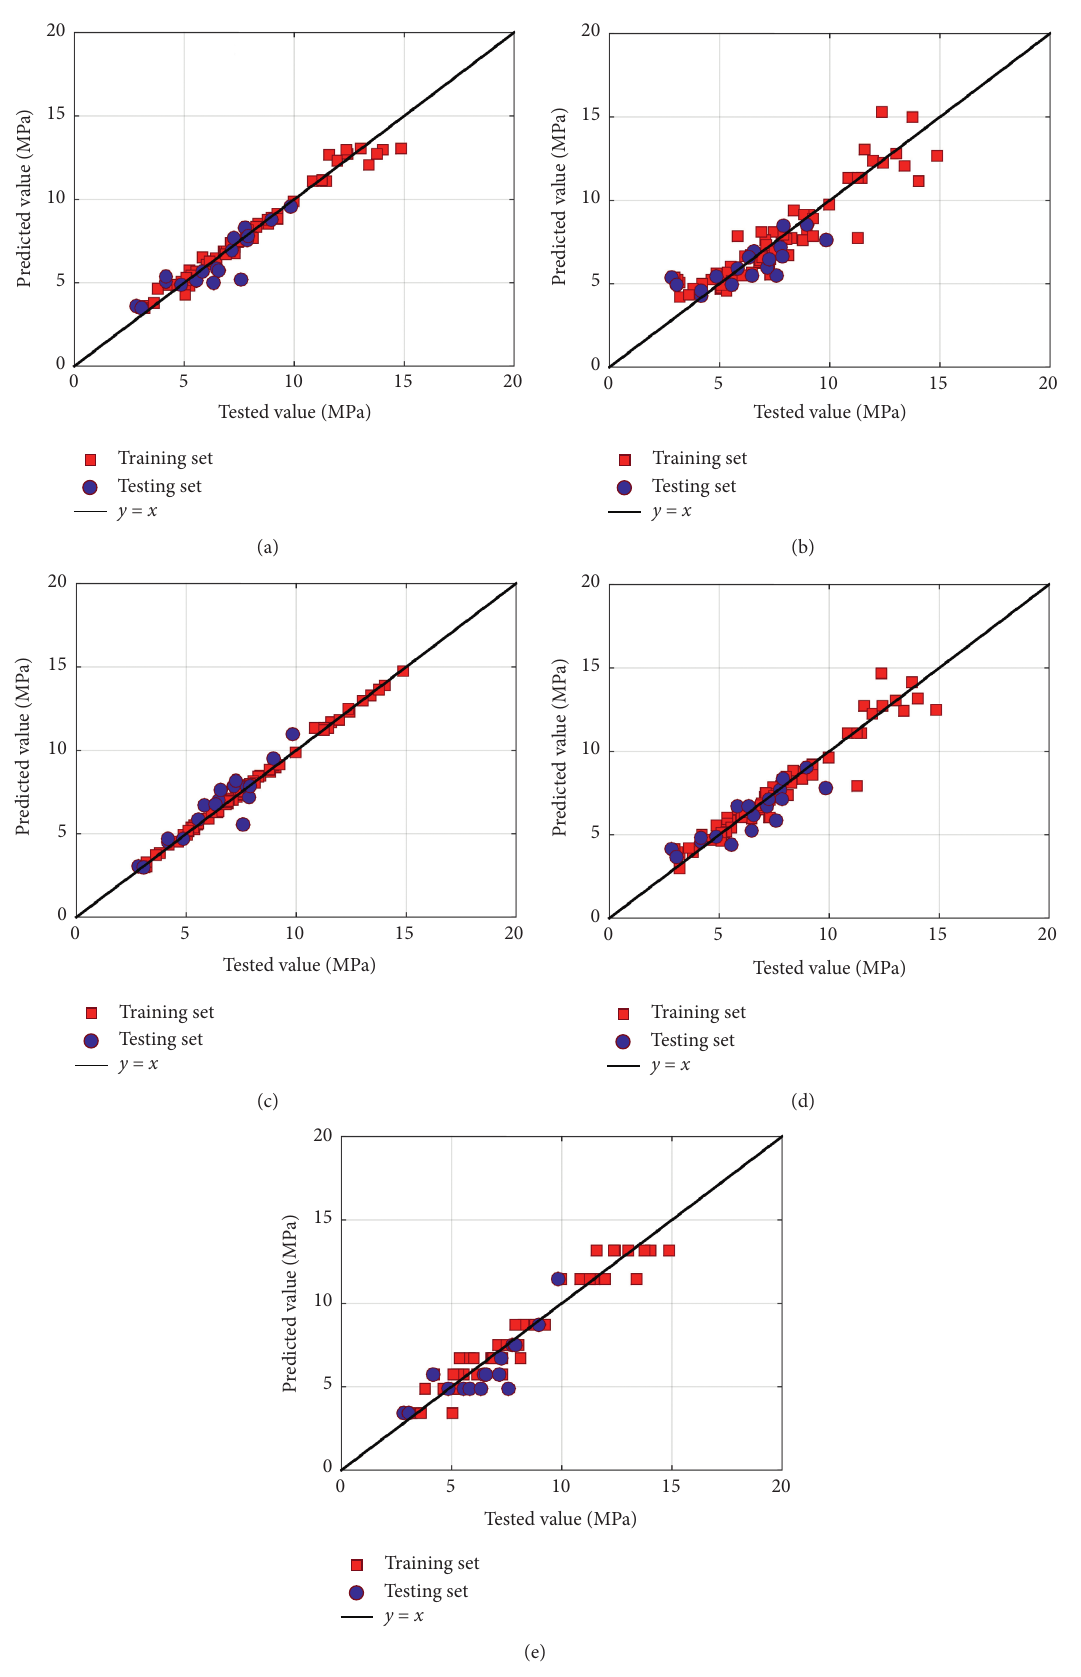
Figure 3: Prediction results of different ML models: (a) GBRT. (b) LR. (c) SVM. (d) ANN. (e)